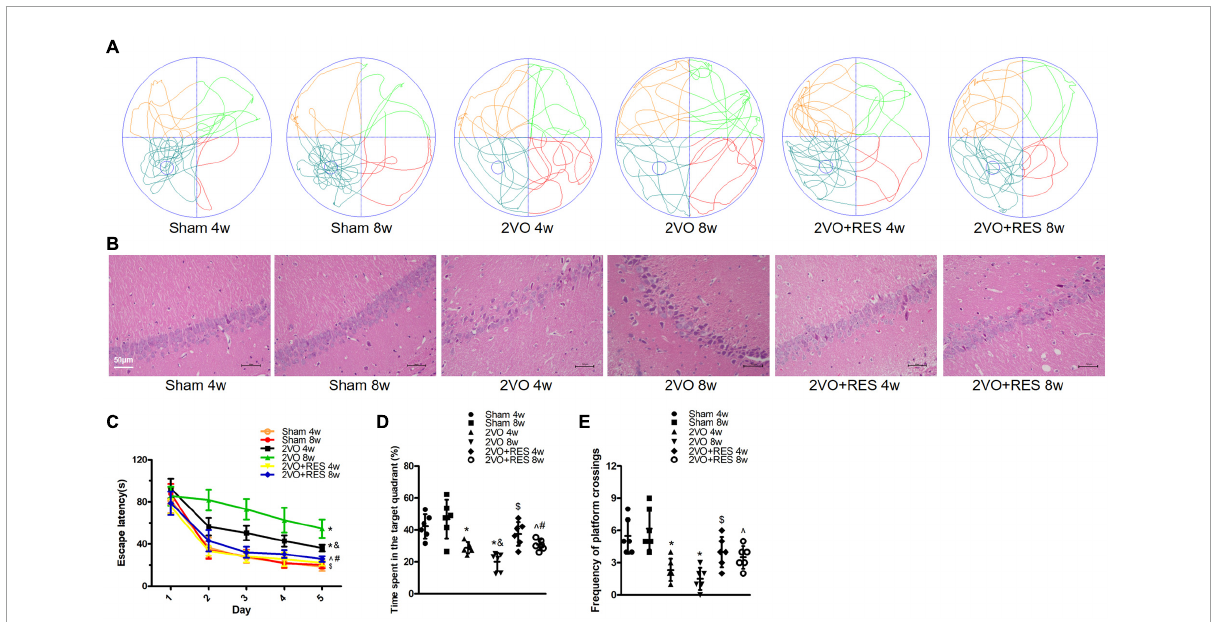
FIGURE2 Resveratrol (RES) alleviates cognitive deficits and pathologic changes in the hippocampal CA1 region at 4 and 8 weeks after bilateral common carotid artery occlusion (2VO). (A) Swimming path of rats on day 6 in different groups. (B) Representative images of Hematoxylin–eosin staining in the hippocampal CA1 region ( × 200, scale bar, 50 µ m). (C) Escape latency from day 1 to day 5. (D) Probe trial on day 6. (E) Frequency of platform crossings. Morris water maze test, n = 6 per group; Hematoxylin–eosin staining, n = 3 per group. * p < 0.05 vs. Sham; & p < 0.05,